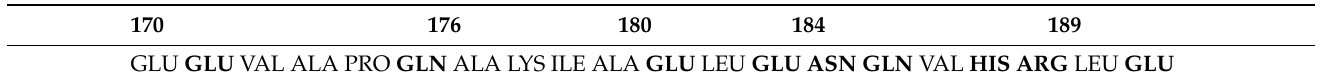
Table 2. The isolated fragment to form the ligand (peptide named LETI-11) to bind to lactoferrin. 170 176 180